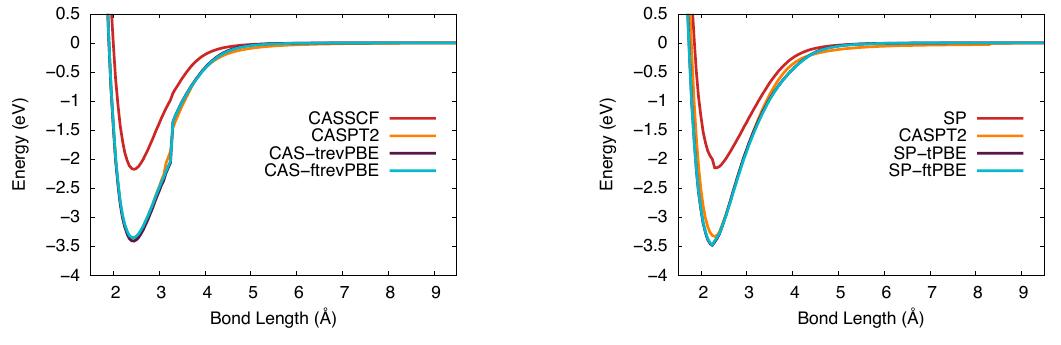
Figure 6. The potential energy curve for niobium silicide in the 4 Π ground state. ( Left ): CASSCF (red), CASPT2 (orange), CAS-tPBE (purple), CAS-ftPBE (blue). ( Right ): SP (red), SP-tPBE (purple), SP-ftPBE (blue), CASPT2